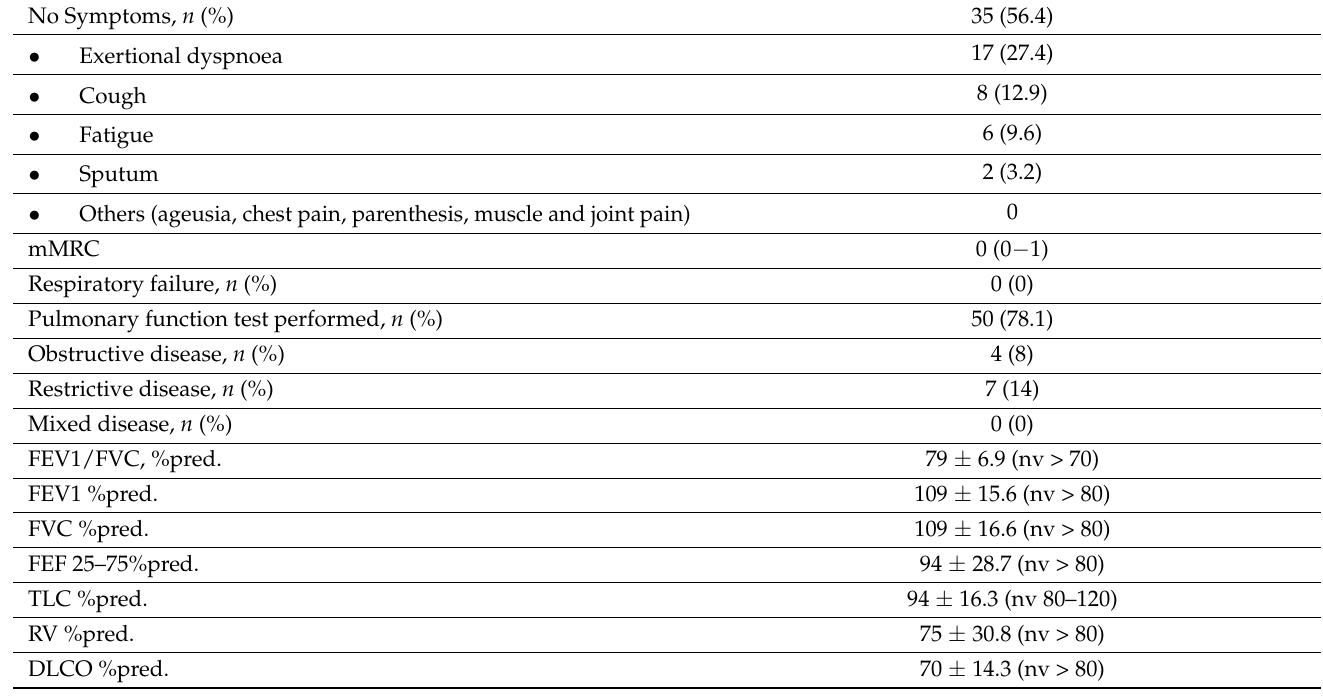
Table 3. Clinical findings and respiratory function at follow-up